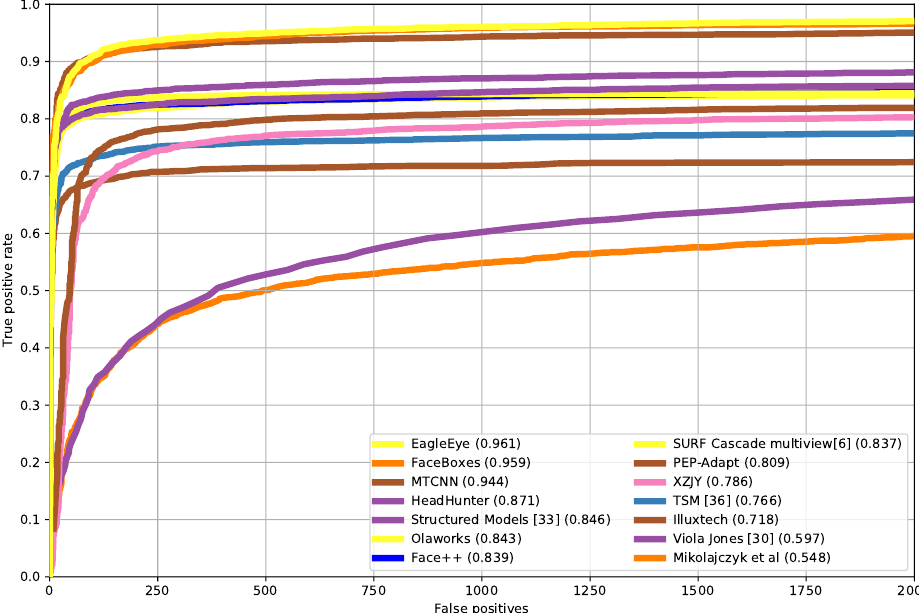
Figure 10. Discontinuous receiver operating characteristic (ROC) curves on the FDDB dataset.